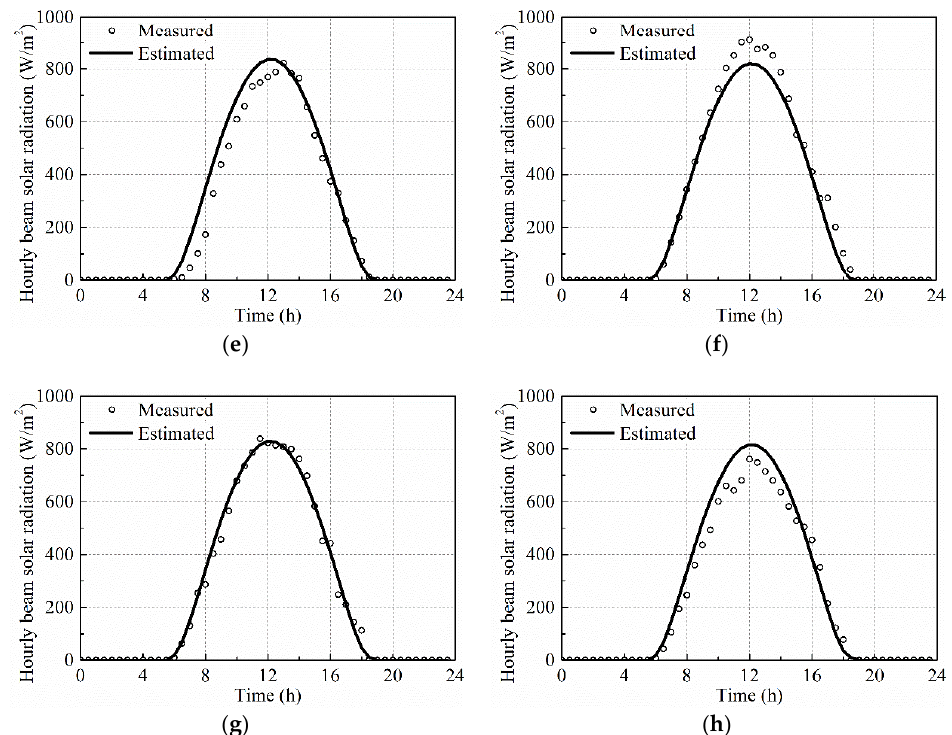
Figure 6. Comparison between measured and estimated hourly beam solar radiation curves for eight cities in Fujian: ( a ) Fu’an (10 August 2016); ( b ) Jian’ou (7 August 2016); ( c ) Fuzhou (2 August 2010); ( d ) Ninghua (4 August 2016); ( e ) Zhangping (27 July 2016); ( f ) Anxi (2 August 2015); ( g ) Hua’an (30 July 2016); and ( h ) Zhangzhou (31 July 2014).